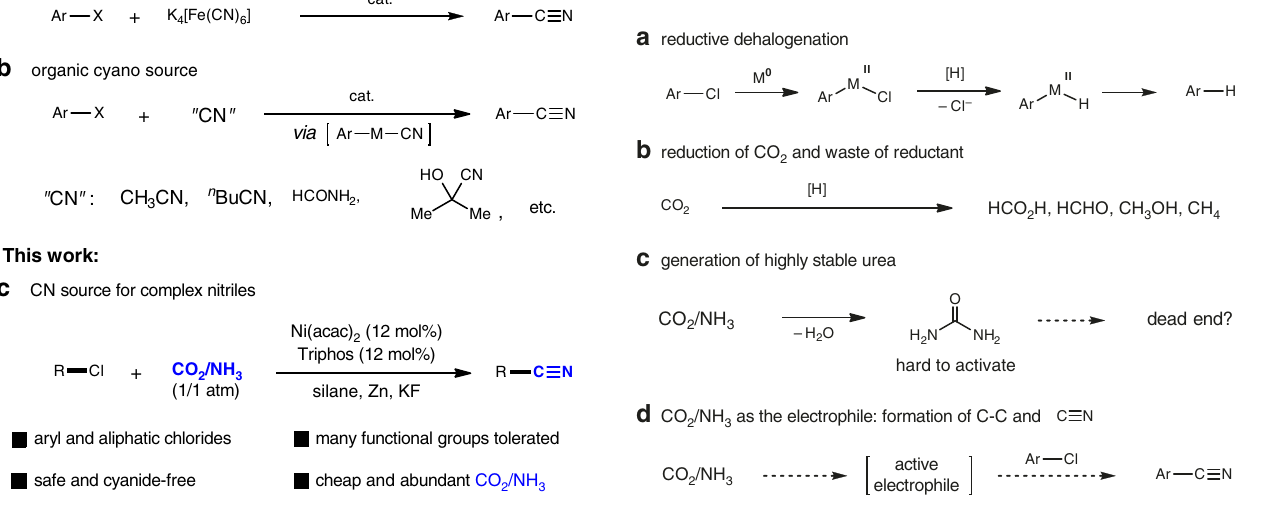
Fig. 2 Challenges for reductive cyanation strategy. a Reductive dehalogenation. b reduction of CO 2 . c The generation of stable urea. d The challenging generation of active